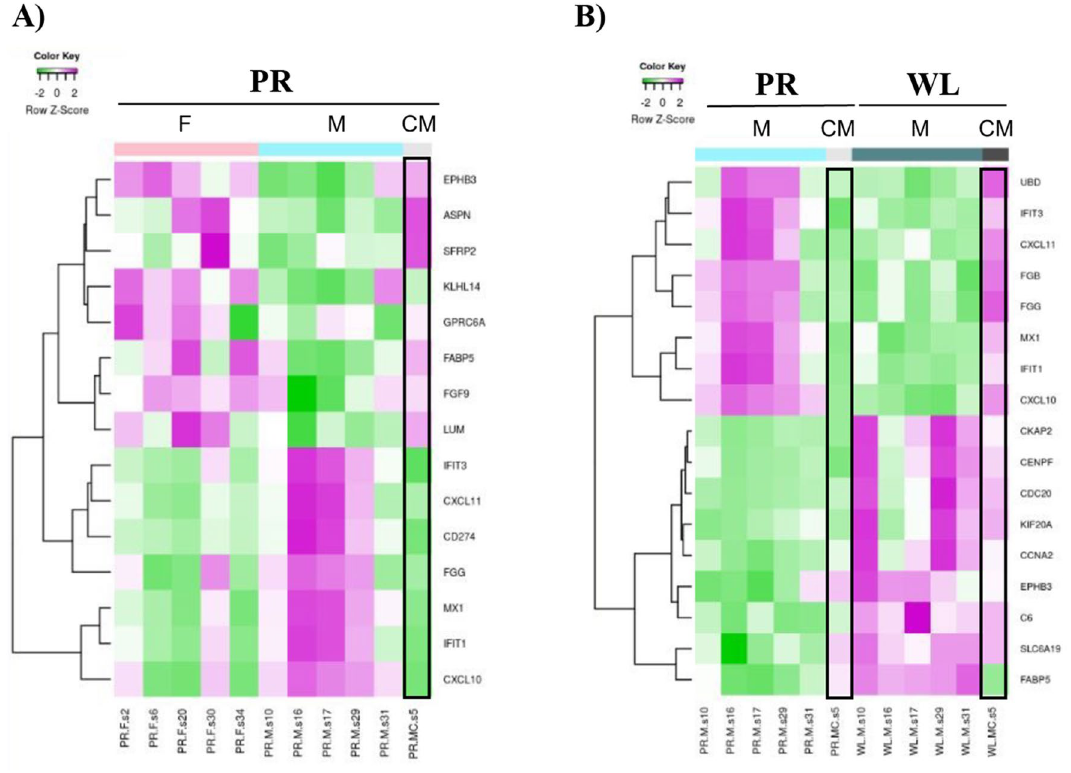
Figure 5. IPA heatmap gene expression representation of top regulated genes. Microarray data files of pig experiments were uploaded in IPA software. Results were reported in hierarchical clustering of top up and down regulated genes in ( A ) a sex- (MPR vs. FPR) and ( B ) time- (MPR vs. MWL) comparisons. Data from a castrated male was compared with male and female pig expression patterns. The castrated male showed a gene expression pattern similar to females. F female, M male, CM castrated male, PR pre-ischemia, WL one week